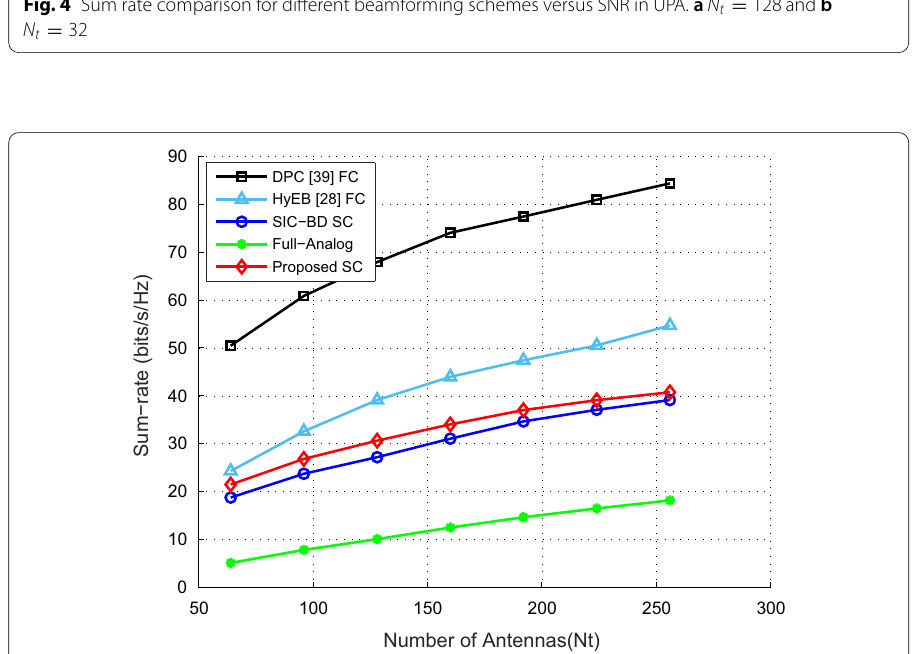
Fig. 5 Sum rate comparison for different hybrid precoding schemes versus the number of BS antennas. The graph shows the result of the number of antennas from 64 to 256 when SNR